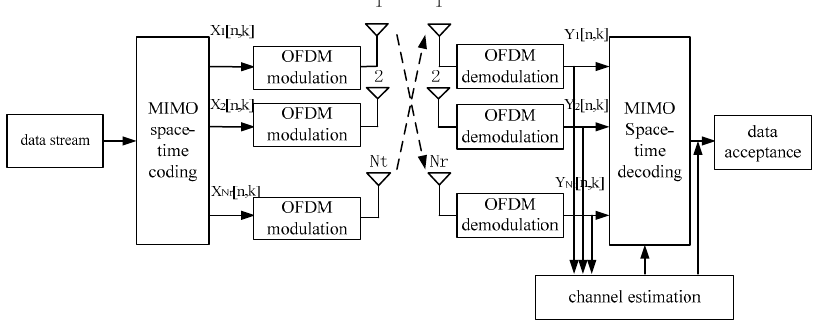
Figure 2. The architecture of a MIMO-OFDM system.